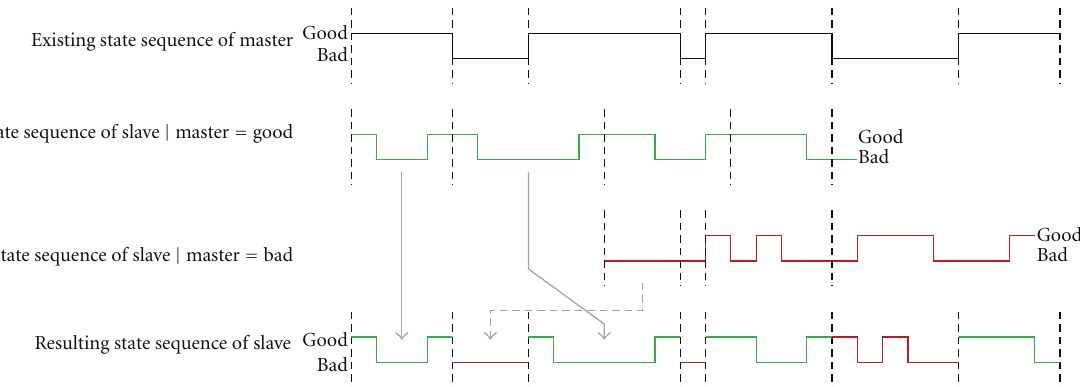
Figure 3: Realisation of Master-Slave with the Conditional Assembling Method : Given a master sequence, two independent conditional slave sequences are generated for the cases “master is good” and “master is bad.” Di ff erent state models (1st-order Markov, semi-Markov, etc.) can be chosen individually therefore. Finally, the slave sequence is composed by piecewise assembling the two conditional sequences according to the master sequence. In this way the correlation coe ffi cient between master and slave, the individual state probabilities, and the combined state probabilities can be accurately described.